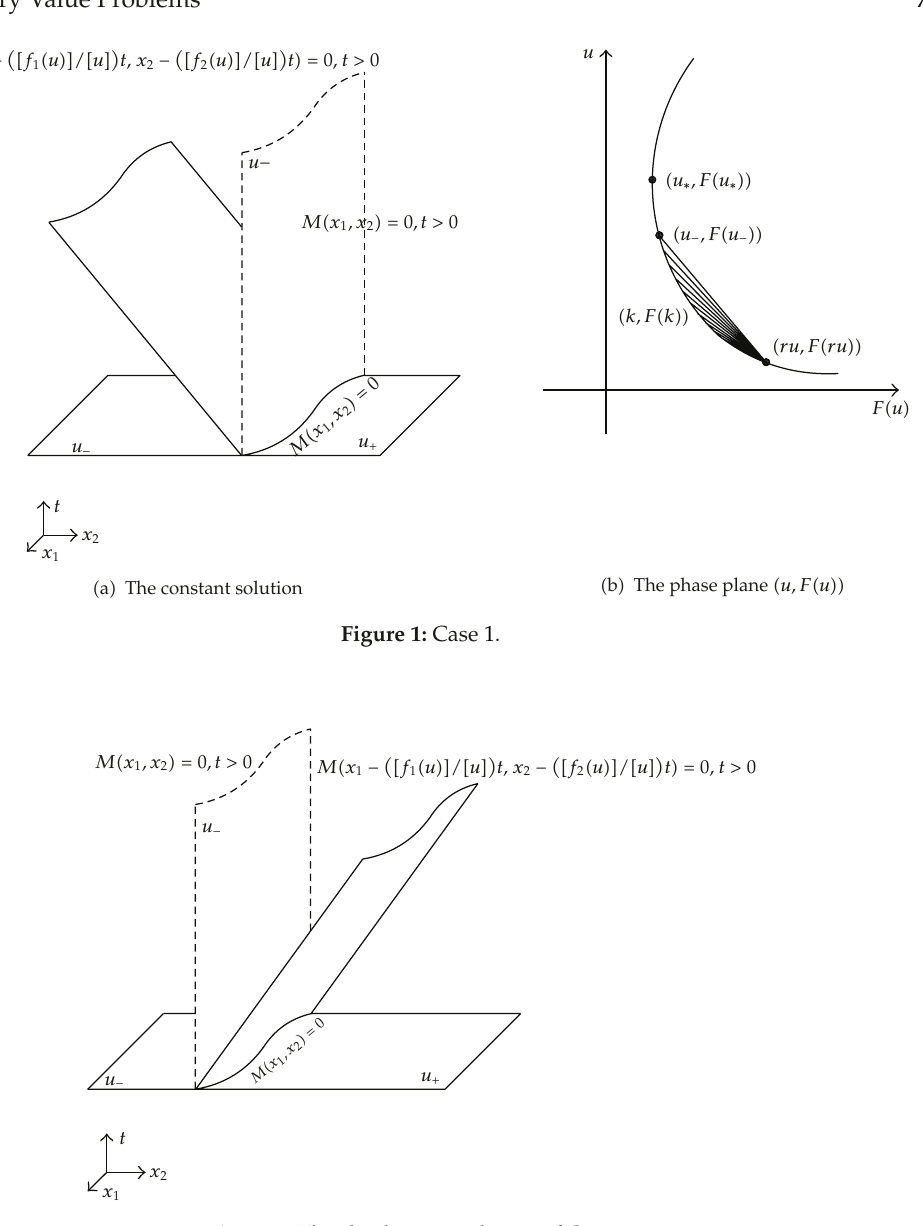
Figure 2: The shock wave solution of Case